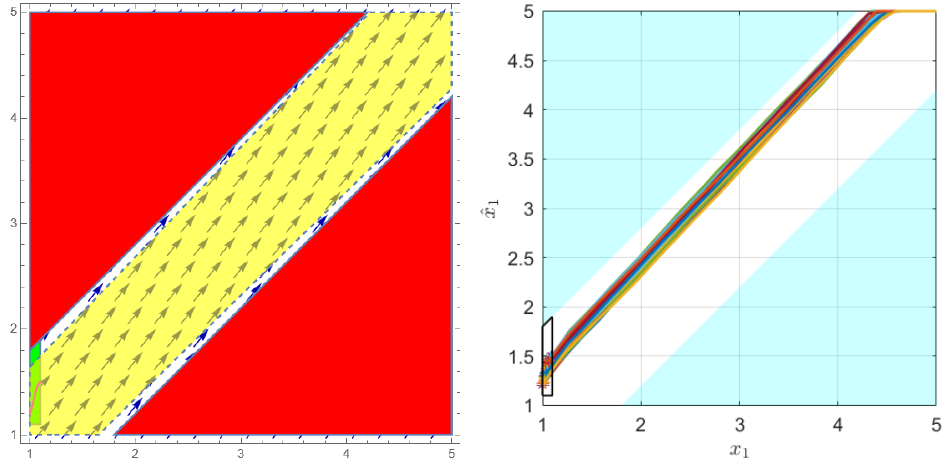
Figure 5. ( Left ) Phase portrait of Example 2 with x 2 = ˆ x 2 = 0.05. The pink line and the green, red, and yellow regions are the initial sets (cid:101) Θ 0 and Θ 0 , the unsafe set Θ u , and the sub-level set of B ( x , ˆ x ) , respectively. ( Right ) State runs of Π × Π on the projection of the x 1 plane starting from (cid:101) Θ 0 . The blue region represents the unsafe set Θ u .